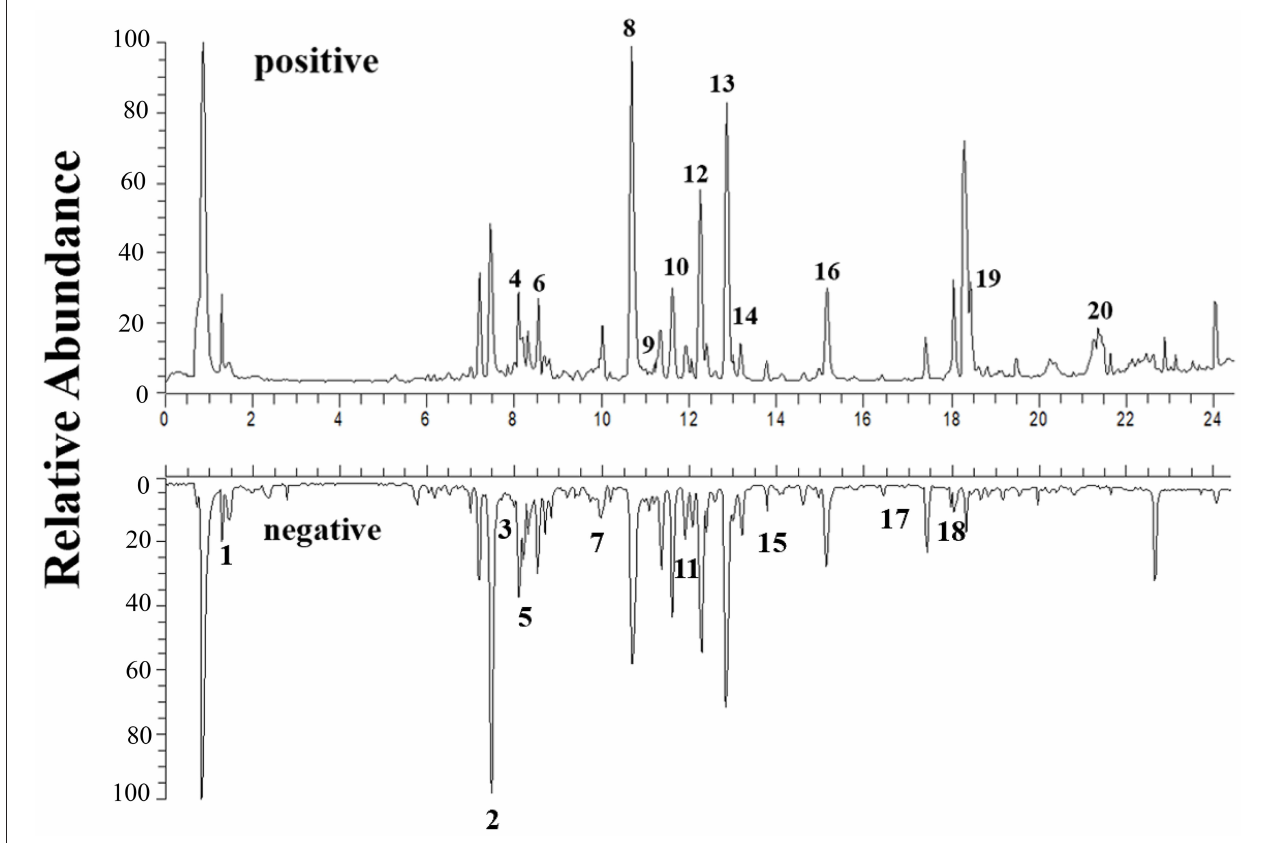
FIGURE 2 | The total ion current chromatogram in positive and negative ion mode for